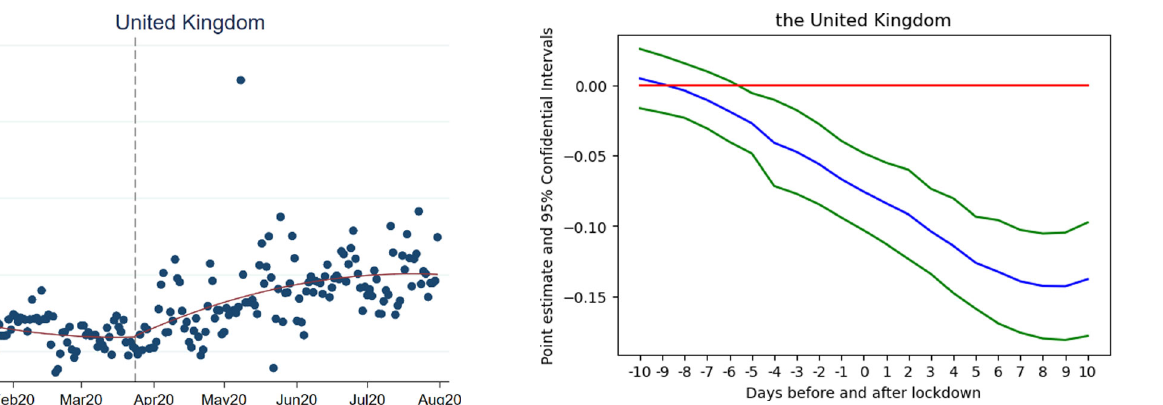
Fig. 4 Bin-scatter plots of regression residuals, January – August 2020. Notes : Quadratic trends are shown in red curves. The behavioural tendency to listen to old music followed a downward trend before the lockdown was imposed, which is indicated by the dashed vertical line. The preference took an upward turn after the fi rst lockdown day and gradually went up over time. Source: Author ’ s analysis and illustration of Spotify